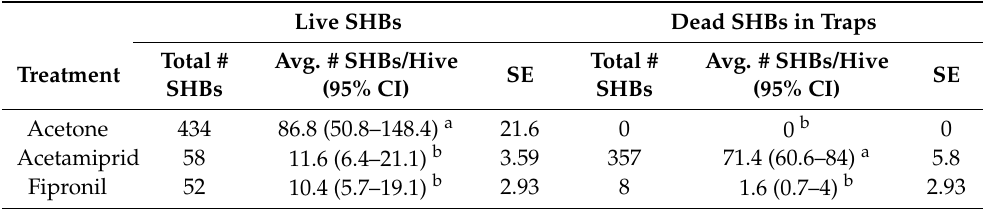
Table 3. Total number, average, 95% confidence intervals, and standard error of live and dead small hive beetles (SHBs) collected after two weeks of treatment exposure via CD trap. Live